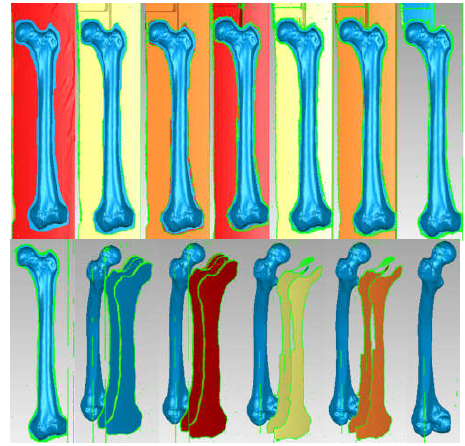
Figure 29. Steps to remove additional surfaces in Geomagic.